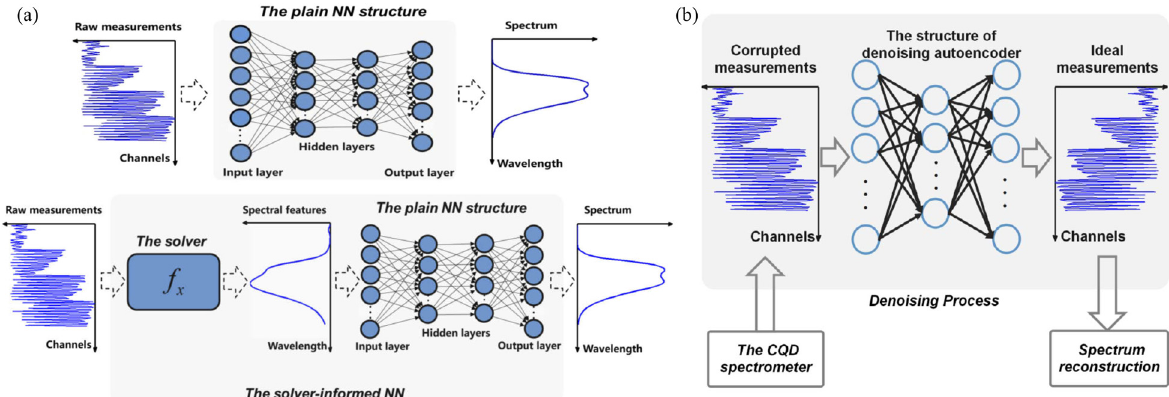
Figure 6: The proposedsolver-informed NNand denoising autoencoderarchitecture used forspectrumreconstruction. (a) The architecture of the plain NN (top): taking pairs of raw measurements and the true spectrum as input and output, the flowchart of the solver-informed NN (bottom) includes applying a specific spectrum reconstruction solver to extract spectral features from the raw measurements and using the spectral features as an input of the NN to learn a map from the features to the true spectrum. (b) The denoising autoencoder architecture with one pair of input and output. The input and output layers match the corrupted and ideal measurements of the CQD spectrometer. (a) is reprinted with permission from Ref. [36], copyright 2021 Optical Society of America; (b) is reprinted with permission from Ref. [37], copyright 2021